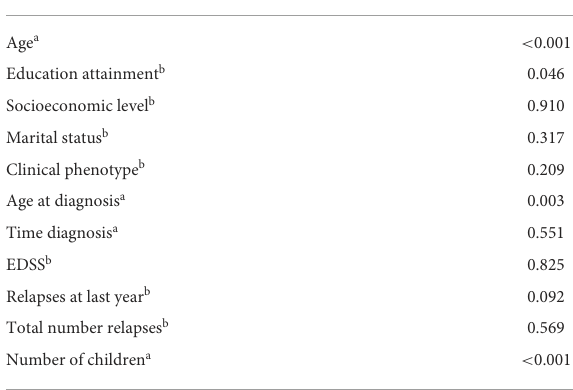
TABLE 1 Demographic and clinical variables. TABLE 2 Bivariate analyses ( N = 139).